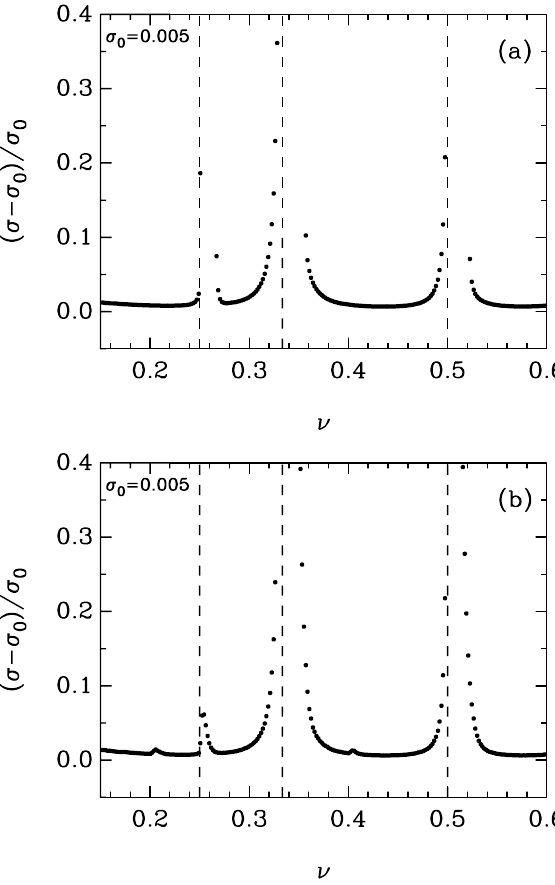
FIG. 7. The relative increase of the asymptotic equilibrium value of the rms emittance s as a function of n calculated by (a) using the moment map (73) and (b) the direct tracking of the phase-space grid points for the system with a sextupole and an octupole kick. The initial rms emittance s (cid:48) (cid:173) (cid:53) 3 (cid:49)(cid:48) 2 (cid:51) , and a (cid:173) (cid:50) . The dashed lines indicate n (cid:173) (cid:49) that the tune shifts at resonant . (cid:51)